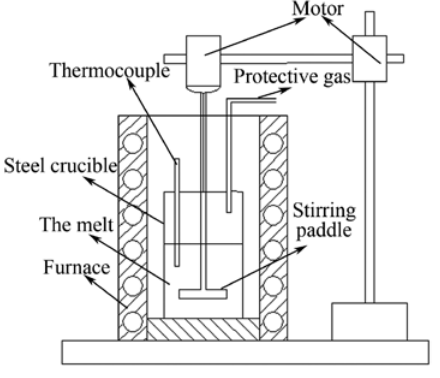
Figure 1: The experimental setup for preparing the FAC/AZ91D